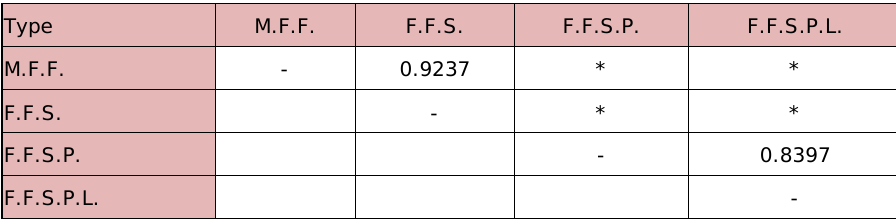
Table 6. “Fisher’s LSD on Mean Fixation Duration”. Source:Own contribution.